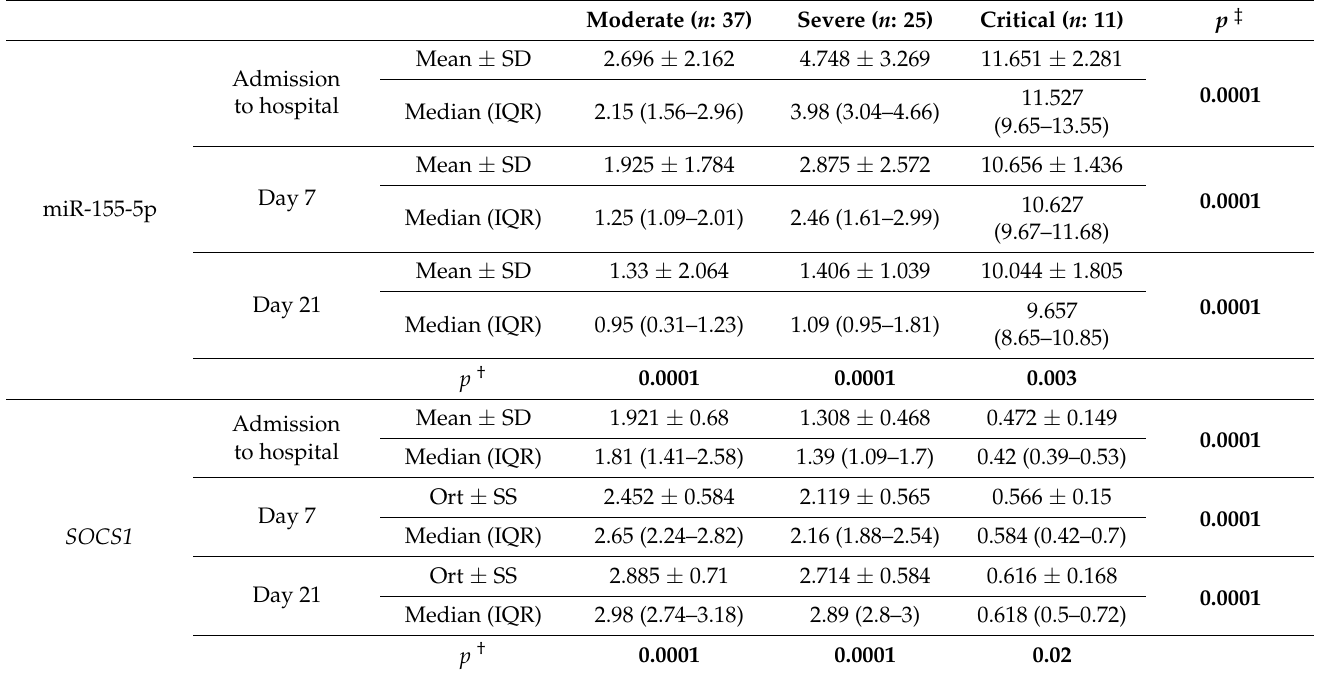
Table 3. Differential expression of miRNA-155 and its target gene SOCS1 in the moderate, severe, and critical group. The relative expression of miR-155 and SOCS1 was determined and expressed as the fold change relative to the control miR-U6 and G6PDH gene. Data are presented as medians and interquartile